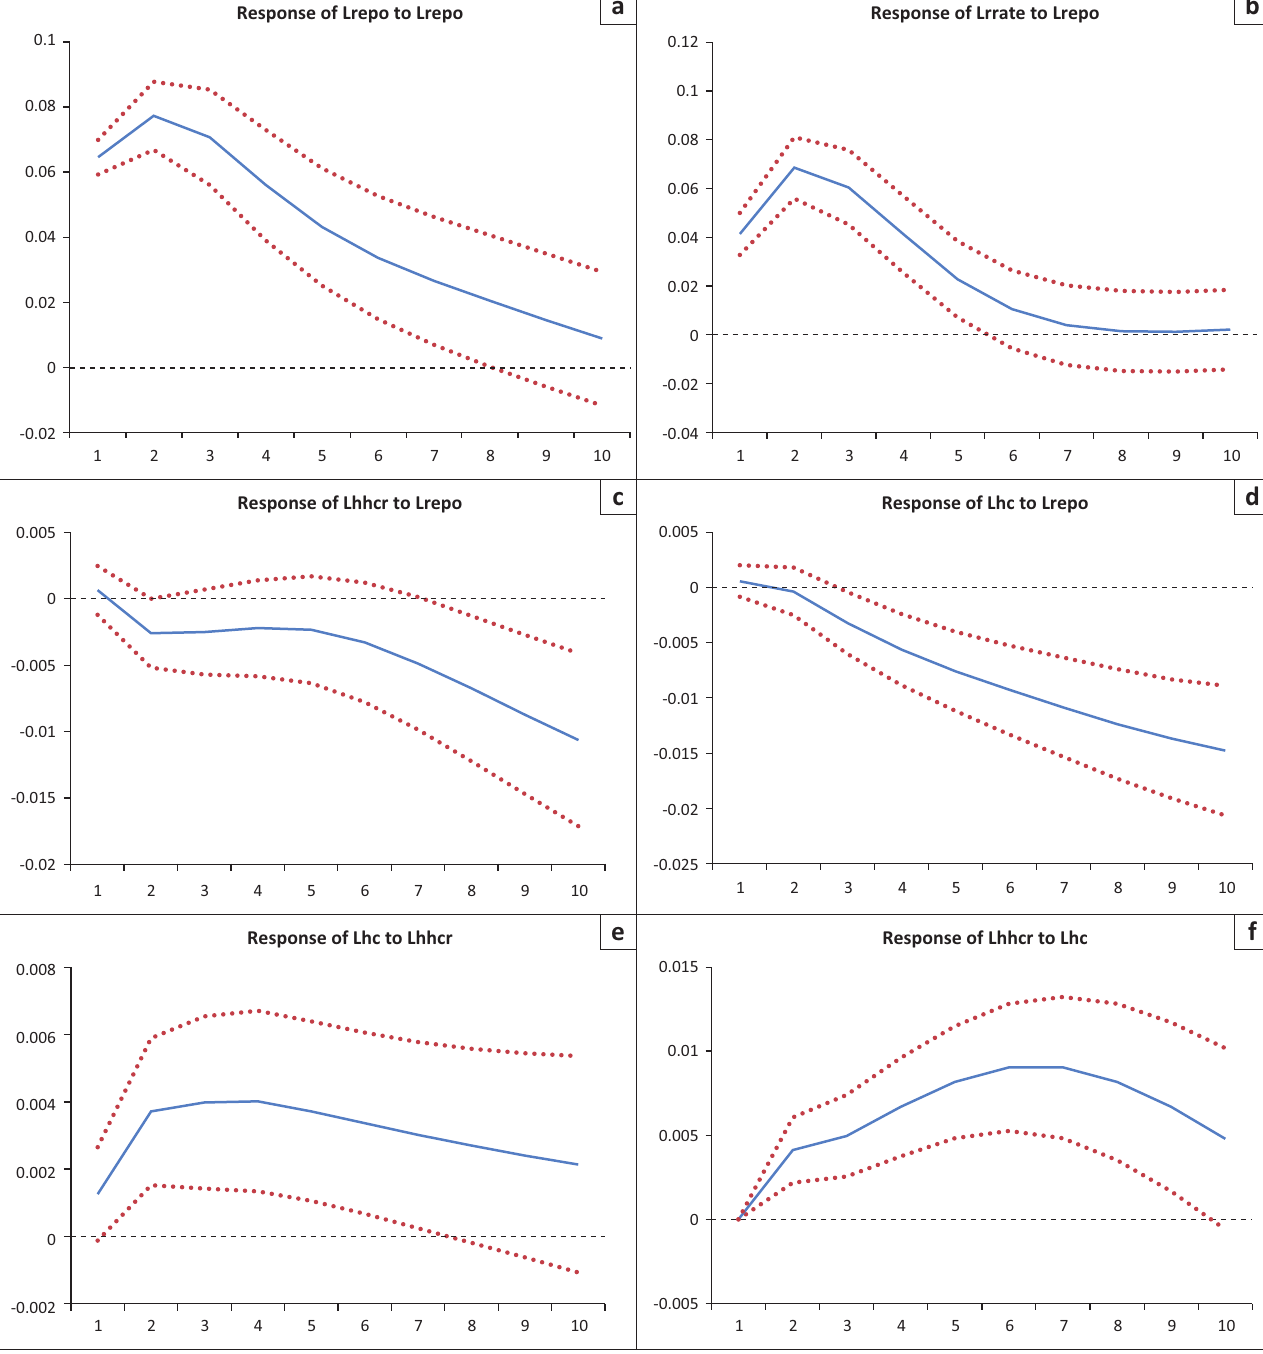
FIGURE 3: Impulse response functions of (a–f) constant parameter VAR model and (g-j) Time-varying impulse responses (TVP-VAR) models ( repo, rrate, hhcr, hc ) to a one standard deviation change in the repo